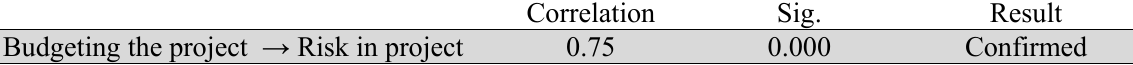
The results of testing the relationship between risk in industrial projects and cost of the